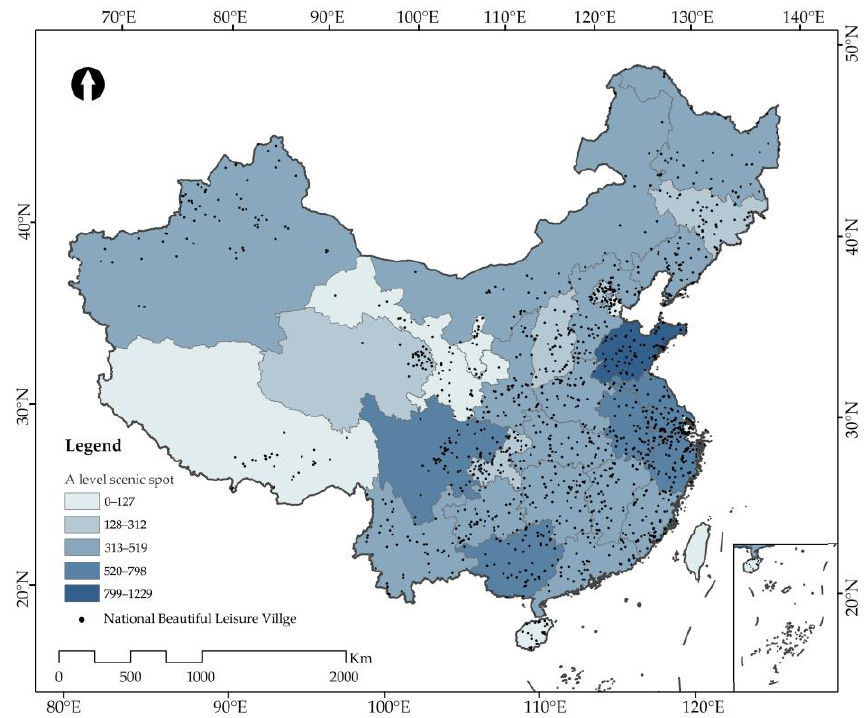
Figure 11. Distribution map overlapping beautiful leisure villages with A-level scenic spots in China.